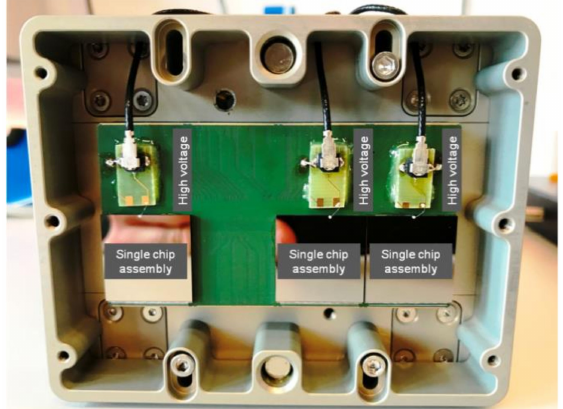
Figure 1. Example of the testbed to evaluate single chip sized sensors connected to JUNGRAU readout chips. The system is based on a modified standard JUNGFRAU multi-ASIC module. In this example three single chip sized hybrid assemblies were mounted. Each hybrid assembly has its own sensor bias voltage connection and can be operated